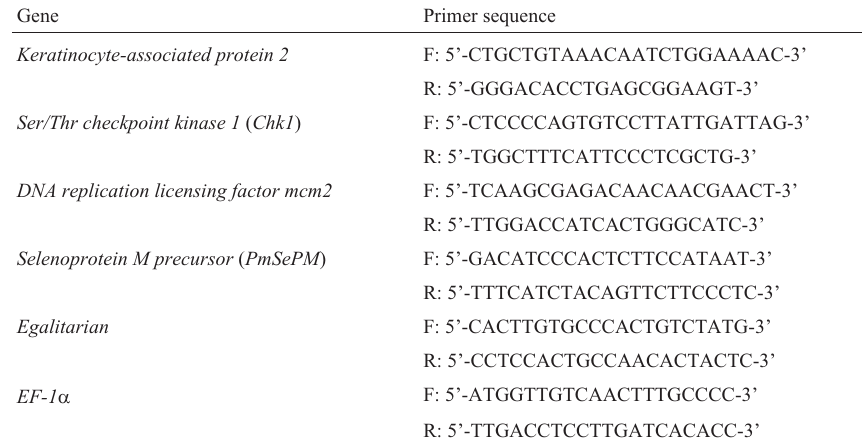
Table 1 - Nucleotide sequences of primers used for expression analysis of keratinocyte-associated protein 2 , Ser/Thr checkpoint kinase 1 , DNA replica- tion licensing factor mcm2 , selenoprotein M precursor and egalitarian in ovaries of wild P. monodon broodstock.